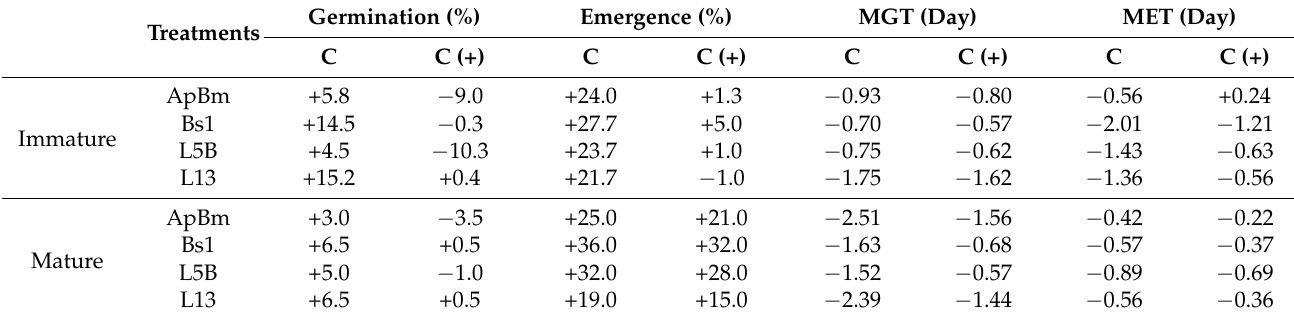
Table 3. Advantage table for the endophytic bacteria strains against control groups for pepper seeds.